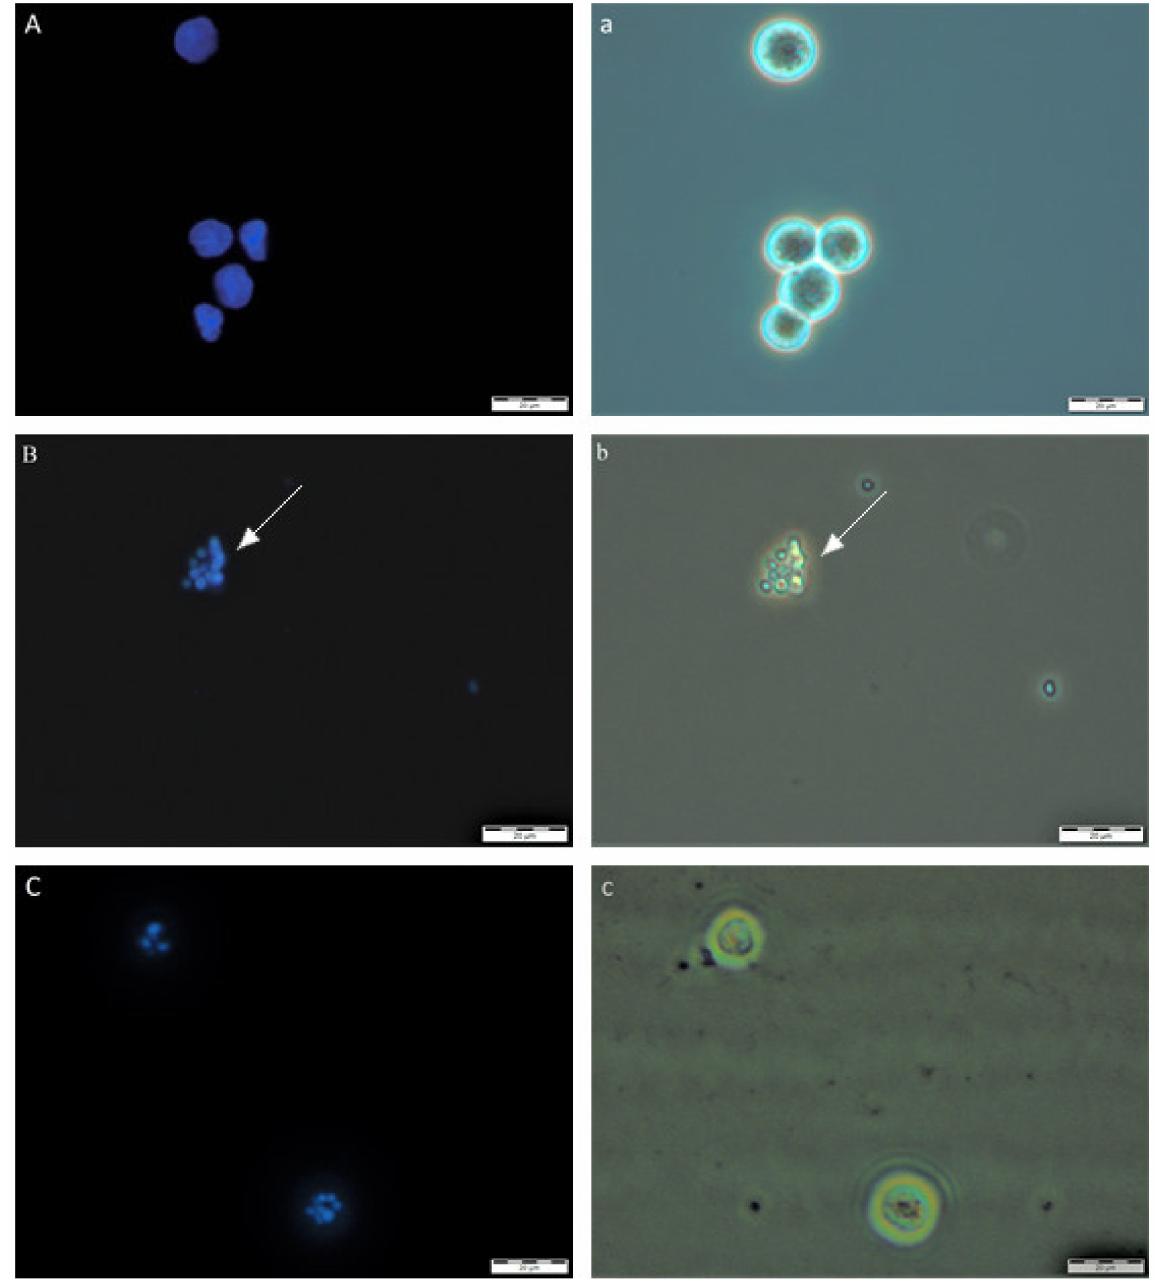
Figure 10. Analysis of cell and nucleus morphology of the AGS cell line treated with 50 µ M of 3 after 72 h. Pictures were taken under fluorescence microscopy with 400 × magnification; Hoechst 33342 dye was used in the experiment. Pictures from the UV filter are described in capital letters, pictures of the contrast phase are indicated with small letters. ( A , a )—cell characteristics in negative control (medium with 1% DMSO); ( B , b )—cells after treatment; ( C , c )—morphological and nucleus changes in positive control (1 µ M